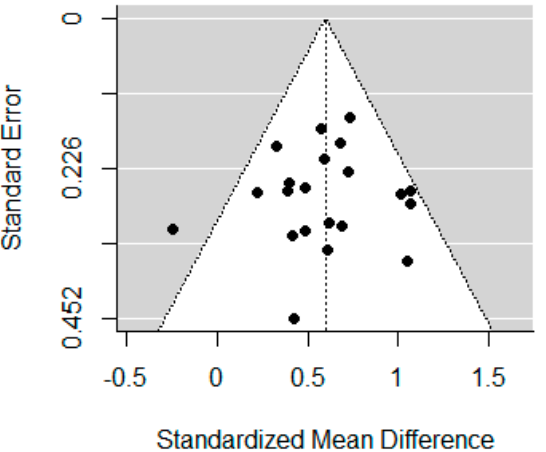
Figure 6. Funnel plot for studies included in the response inhibition meta-analysis.